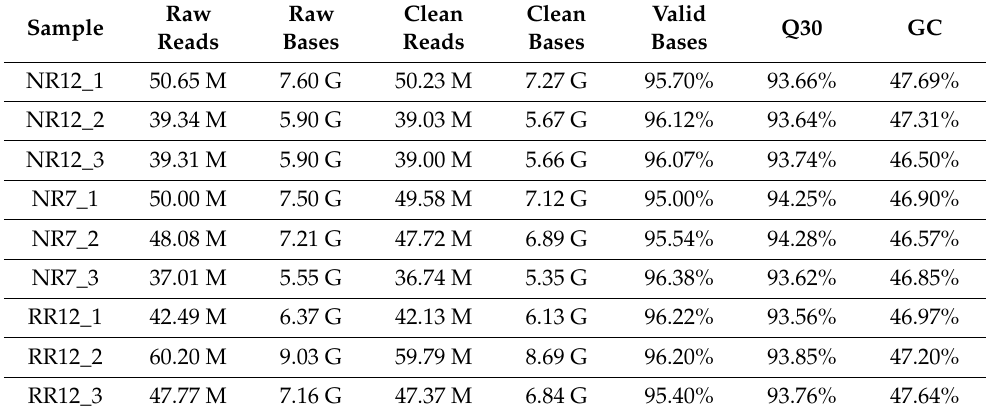
Table 1. The statistical qualification of high throughput